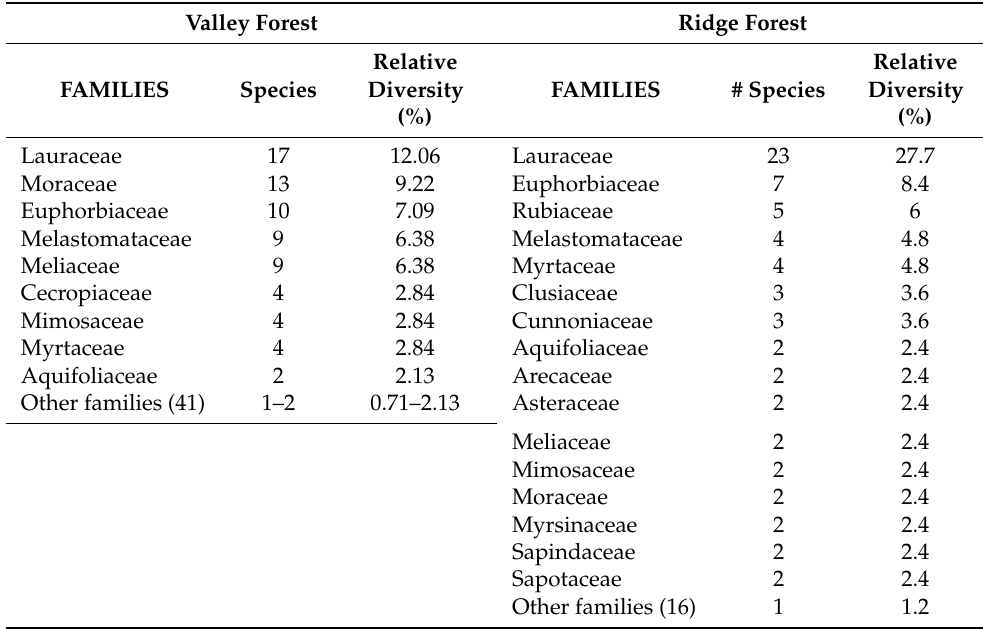
Table 3. Values of relative diversity in both forest types.